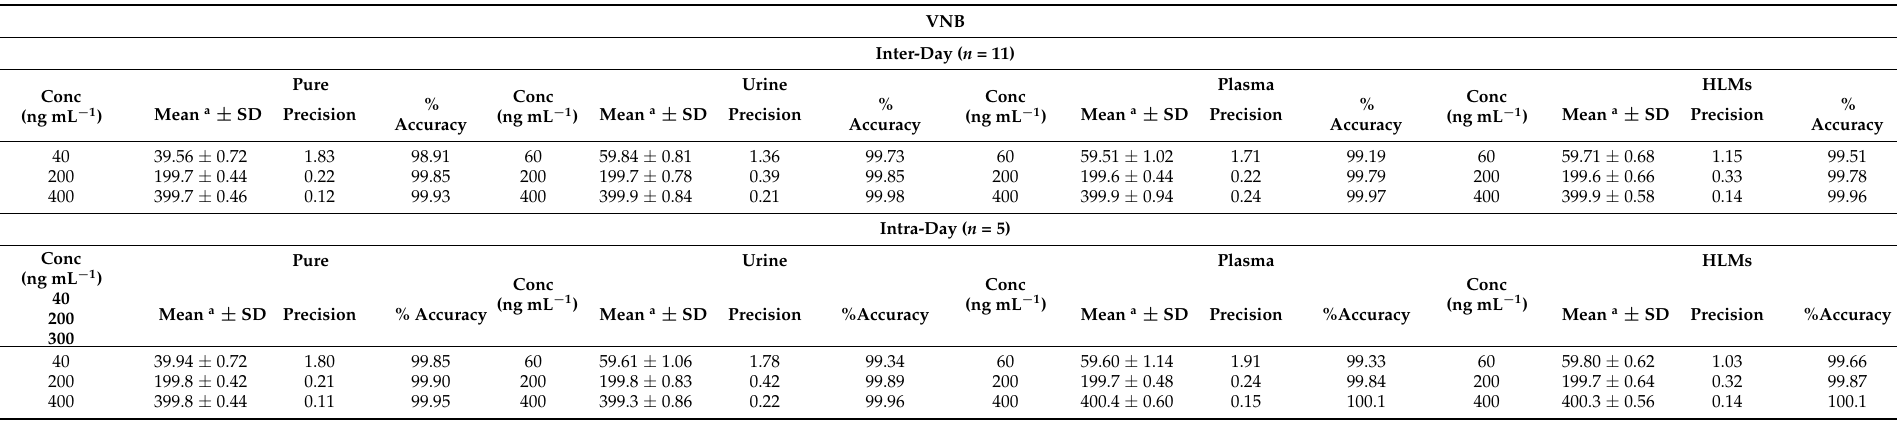
Table 3. Intra-day and inter-day accuracy and precision calculated from quality control (QC) samples for VNB.